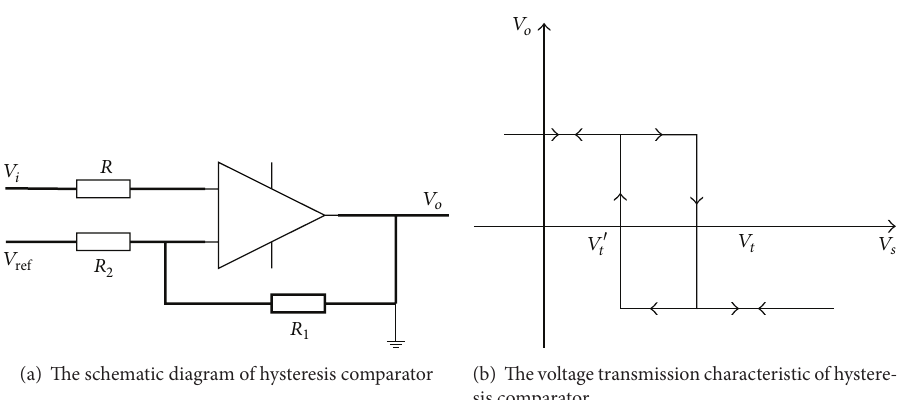
Figure 10: Principle of the hysteresis comparator.